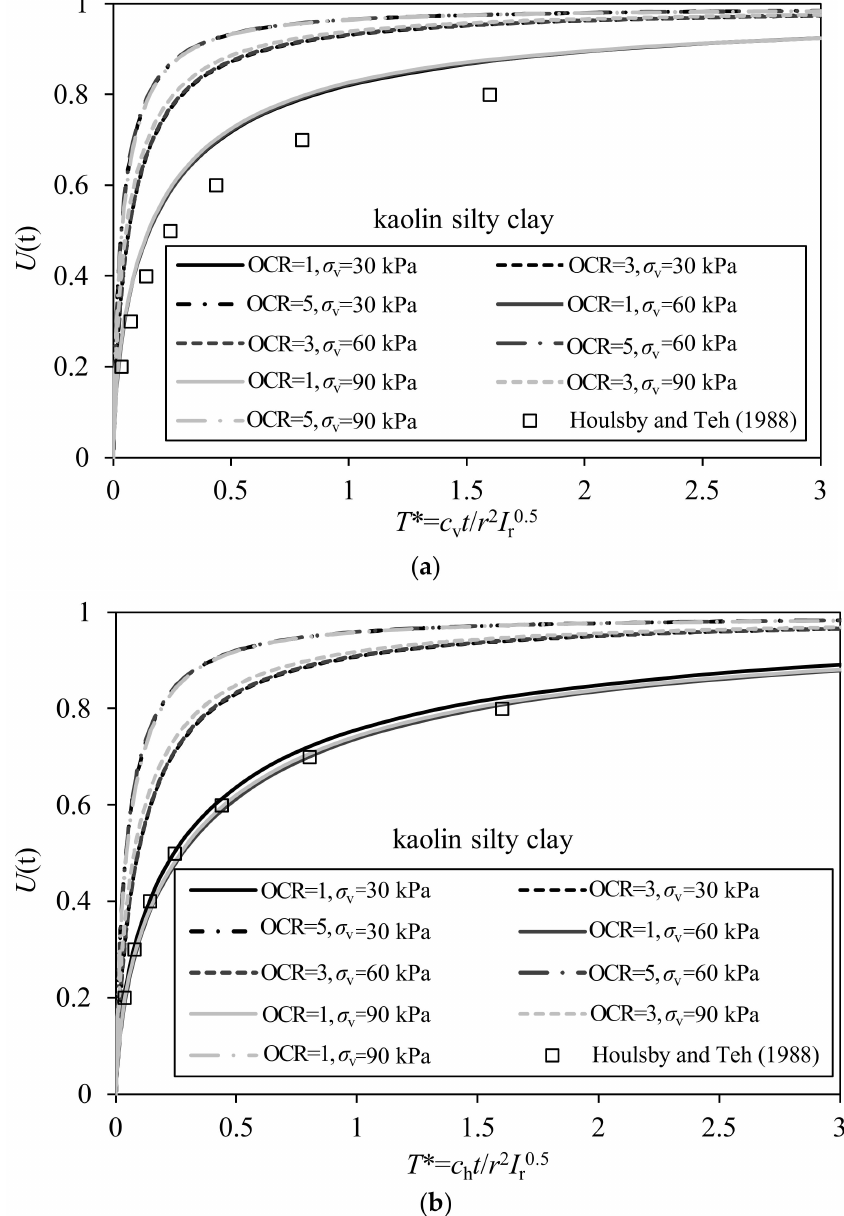
Figure 9. The consolidation degree normalized time curve under different OCR in kaolin silty clay. ( a ) T * normalized with c v ; ( b ) T * normalized with c h